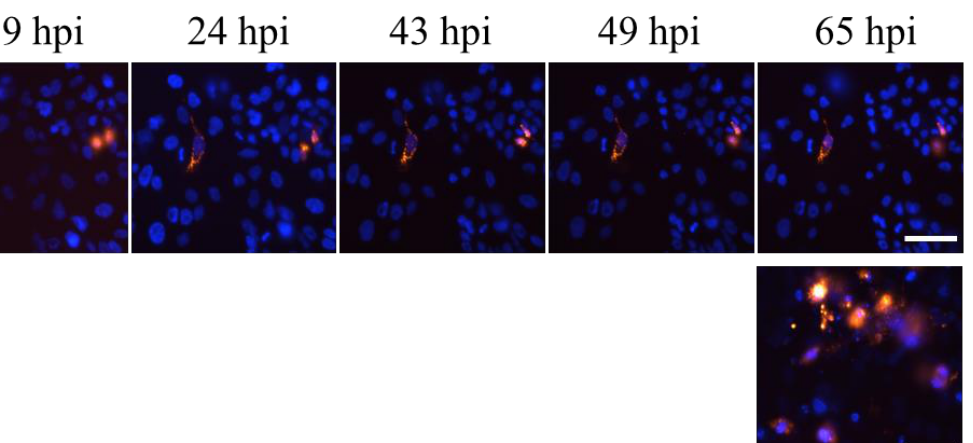
Figure 5. Real-time fluorescence imaging of NS1-RFP IAV infection in 2D Calu-3 cell cultures using MOI 0.01. ( A ) Overview recordings of time-lapse images recorded from 1 hpi to 60 hpi. Arrow heads indicate first RFP-positive cells at 9 hpi. Upper images = transmitted light, lower images = NS1-RFP fluorescence signals. ( B ) A representative example of real-time fluorescence images at a single position during 65 hpi (NS1-RFP signals (red)) shows no changes over time. The image (lower lane, right) presents strong and widespread NS1-RFP signals at 65 hpi within the same cell culture. Experiments were performed three times independently. Nuclei were counterstained with Hoechst 33342 (blue). Scale bars represent 250 µm ( A ) and 25 µm ( B ), respectively.